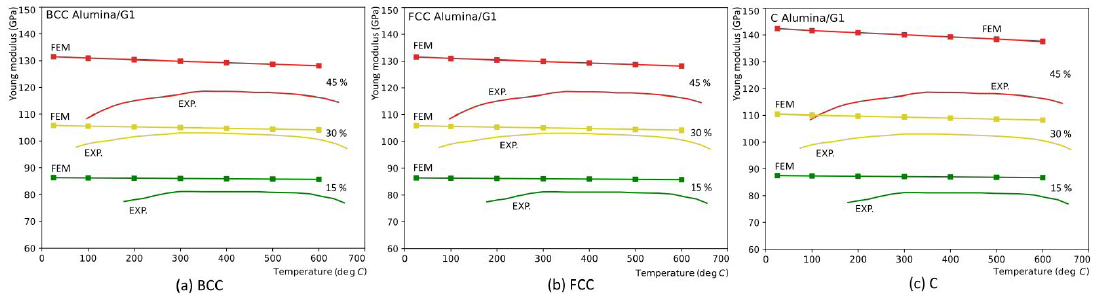
Figure 9. Young modulus obtained for Alumina/G1